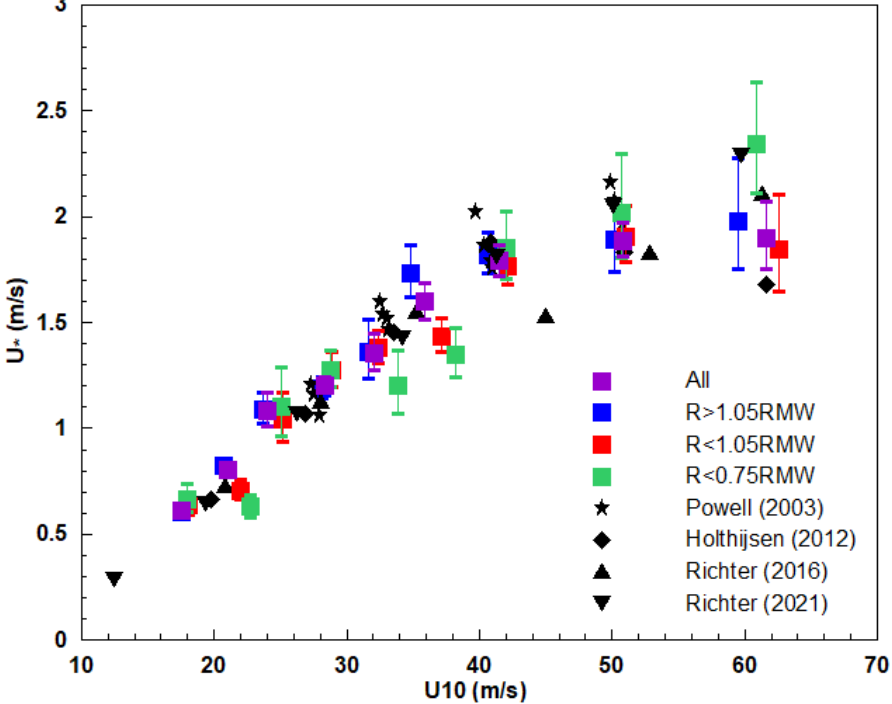
Figure 3. Variation of the friction velocity ( u ∗ , unit: m s − 1 ) with 10-m wind speed ( U 10 , unit: m s − 1 ).